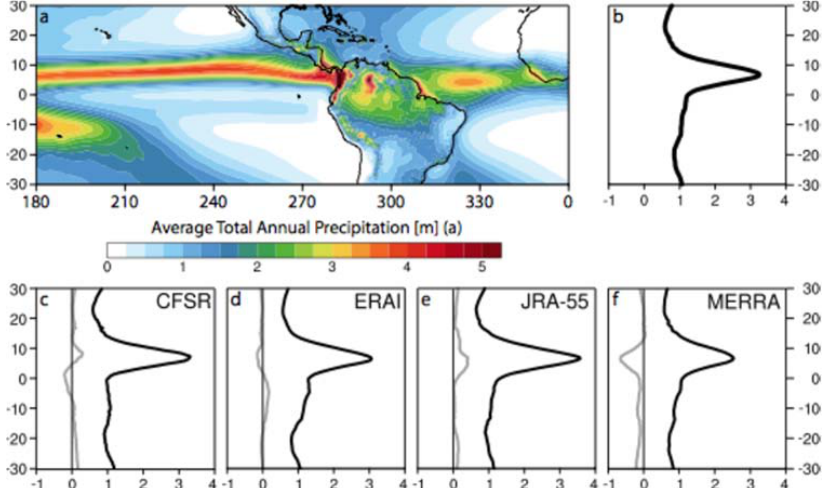
Figure 7. ( a ) The ensemble mean precipitation over the 1981–2010 average for the western hemispheric tropics. The black curve in ( b ) is the ensemble zonal average of precipitation from ( a ). The black curves in ( c – f ) are the respective precipitation zonal averages over the same region as ( a ) for each reanalysis model. The gray curves in ( c – f ) show the differences of the ensemble subtracted from the reanalysis model. The thin black line in ( c – f ) marks zero difference.